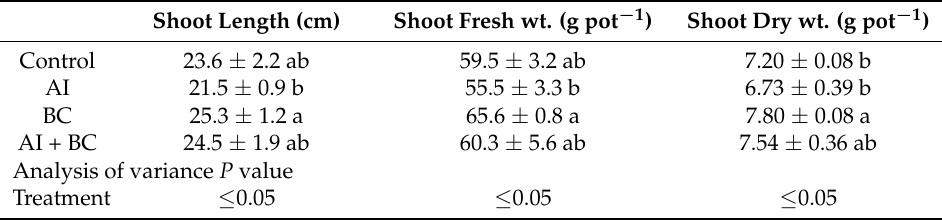
Table 3. Effect of aerated irrigation (AI) and/or biochar (BC) on shoot length, yield, and N content of komatsuna at harvest. Values are mean ± standard deviation ( n = 3). Means followed by the same letters are not significantly different at the P ≤ 5% level by the LSD test.